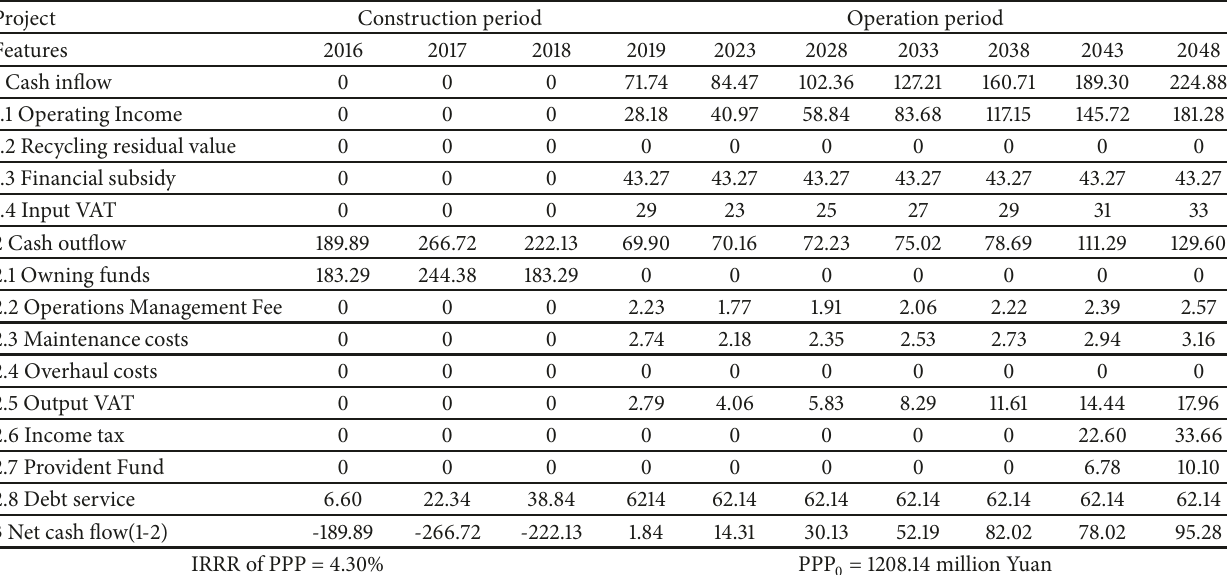
, unit: million Yuan. 0